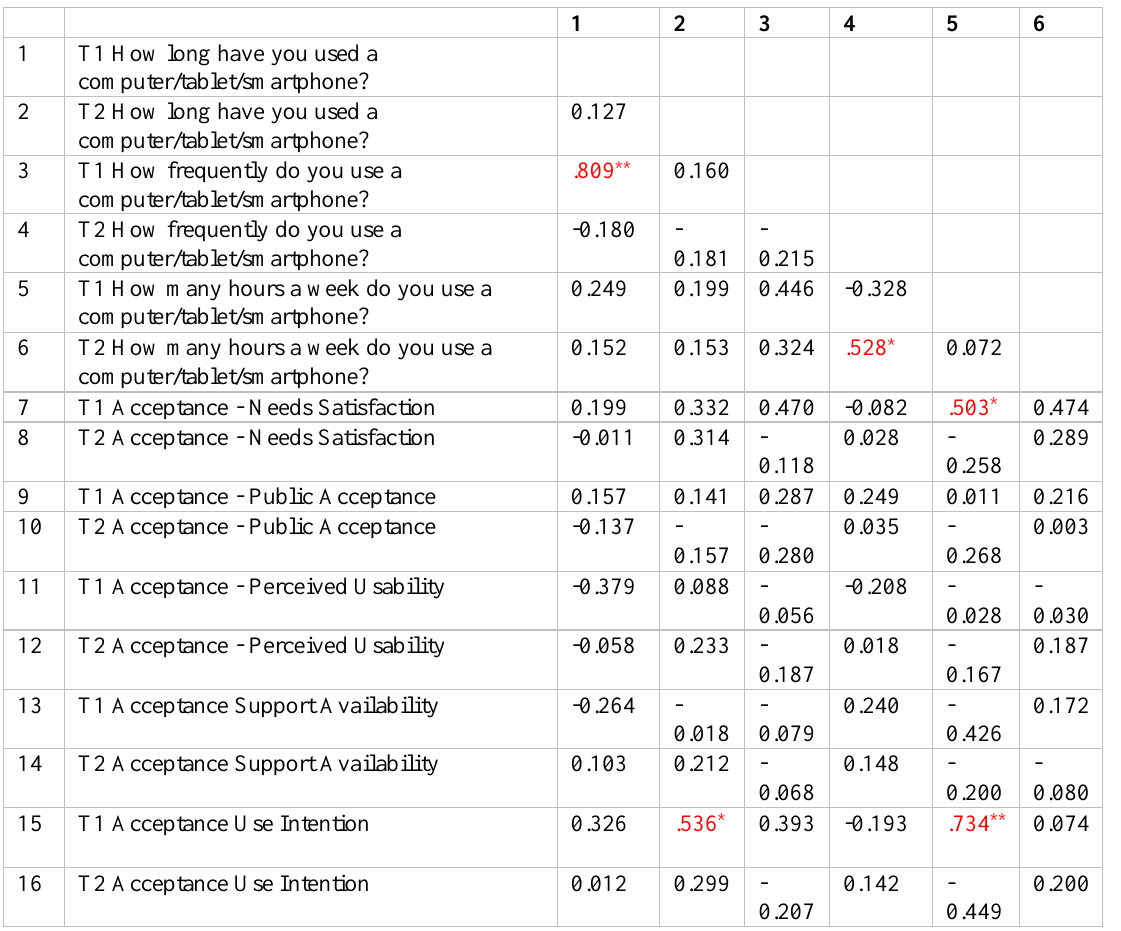
Table 5: Do participants’ experience and usage of technology relate to their acceptance of technology?